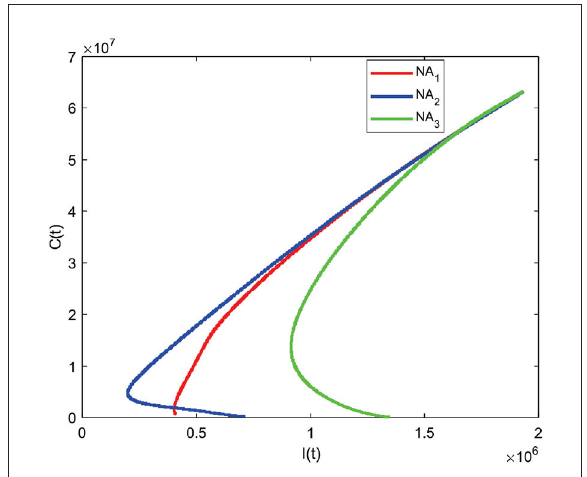
FIGURE3 Projection of three orbits of the model on the I − C